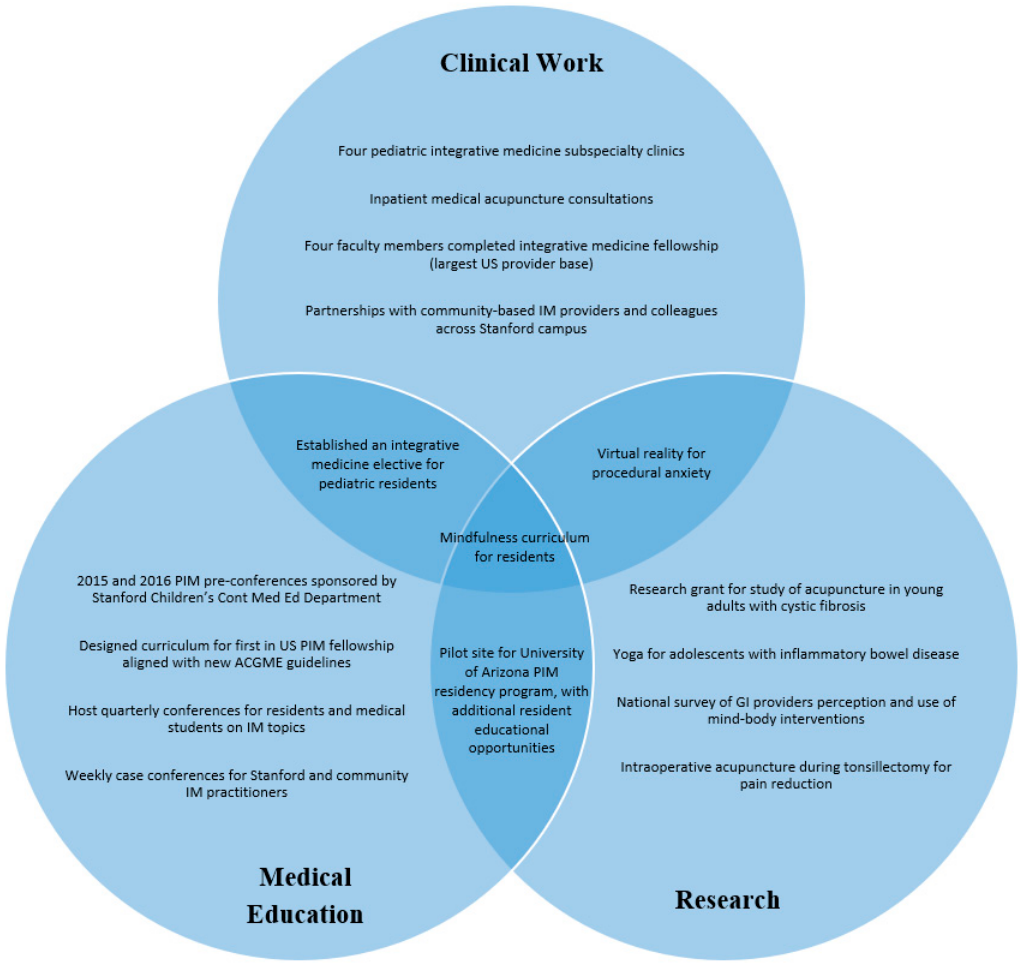
Figure 1. Program accomplishments. IM: integrative medicine; PIM: pediatric IM; GI: gastrointestinal; ACGME: Accreditation Council for Graduate Medical Education.